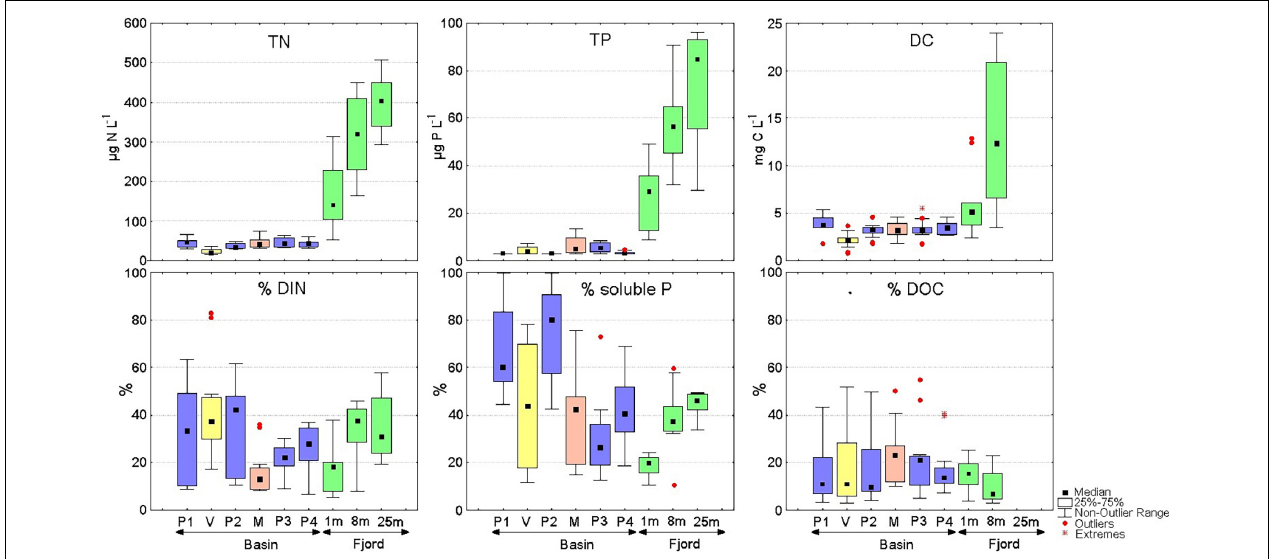
FIGURE 3 | Upper panel: Total nitrogen (TN), total phosphorus (TP) and total dissolved carbon (DC) concentrations measured in the Puelo River (P1-P4), Ventisquero River (V), Manso River (M) and Reloncaví Fjord at three depths ( n = 12). Lower panel: Percentage of dissolved inorganic nitrogen (DIN), soluble phosphorous and dissolved organic carbon (DOC) with respect to the concentrations of the upper